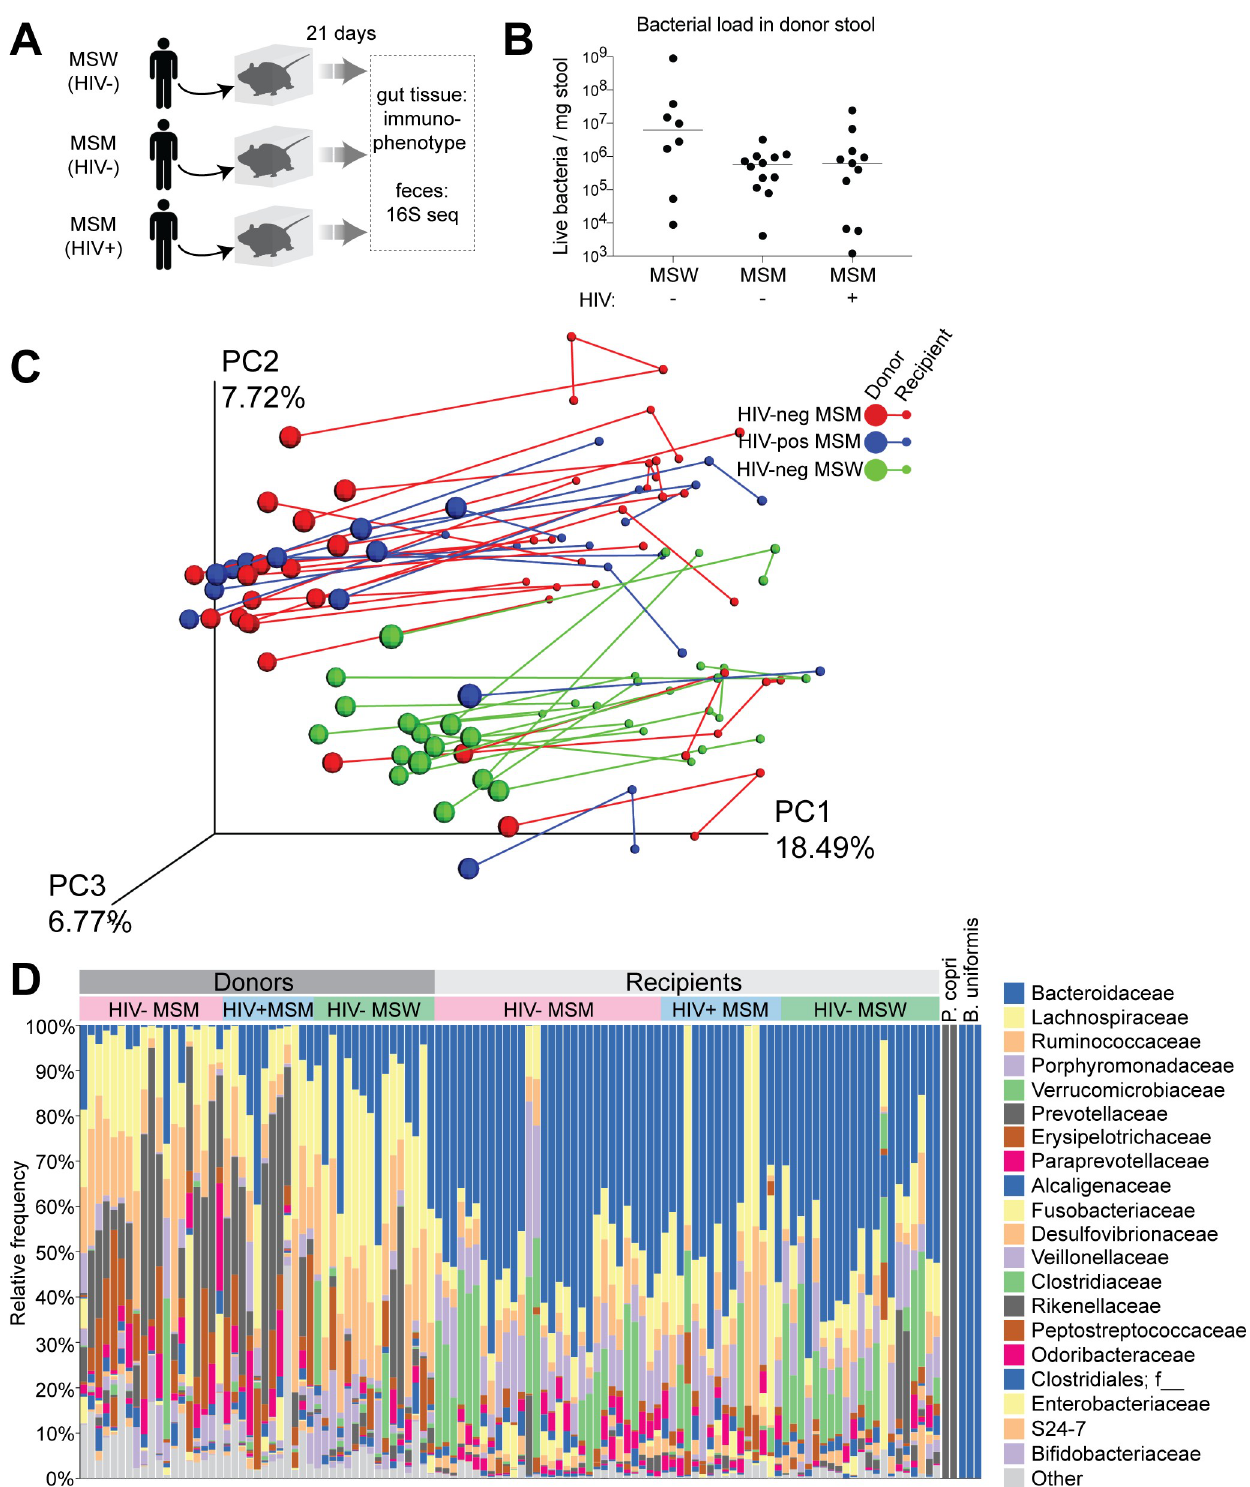
Fig 2. Microbiome composition differences between MSW and MSM are transferred to mouse recipients by fecal transplant. (A) Gnotobiotic mice were gavaged with feces from HIV-negative MSW (n = 16), HIV-negative MSM (n = 19), and HIV-positive MSM (n = 12) donors and sacrificed 21 days post-gavage for immunological analysis and 16S rRNA gene sequencing. (B) Bacterial load in donor stool. Isolated stool bacteria from a subset of donors (8 HIV-negative MSW, 12 HIV-negative MSM, 11 HIV-positive MSM) were stained and counted by flow cytometry. Each data point represents an individual